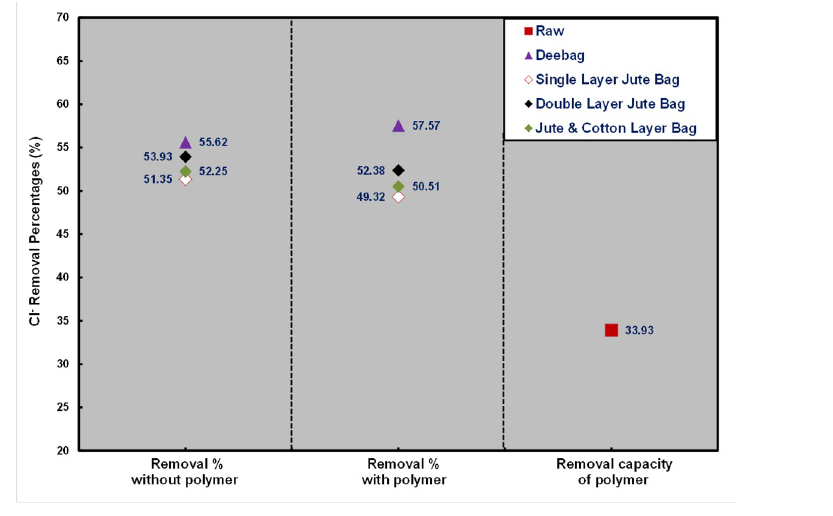
Fig 4. Removal percentages of Cl - .